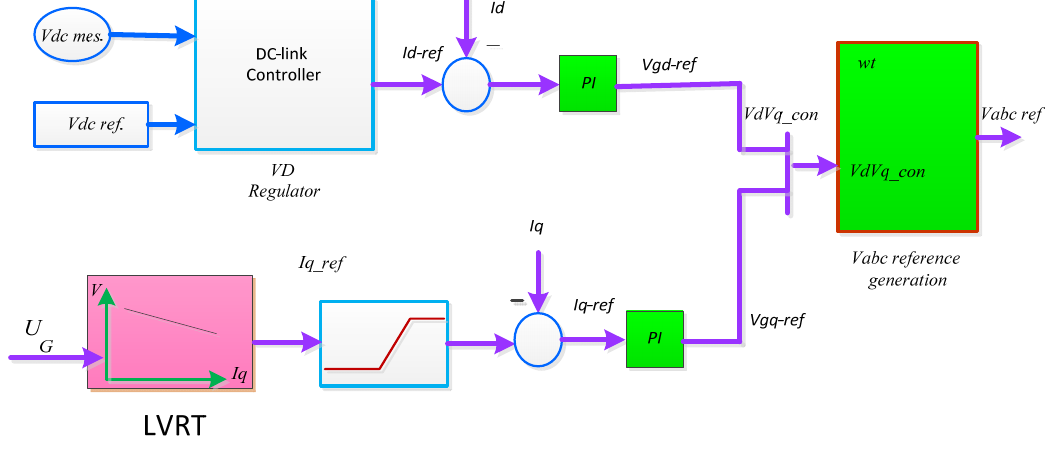
Figure 5. Current regulator using LVRT.